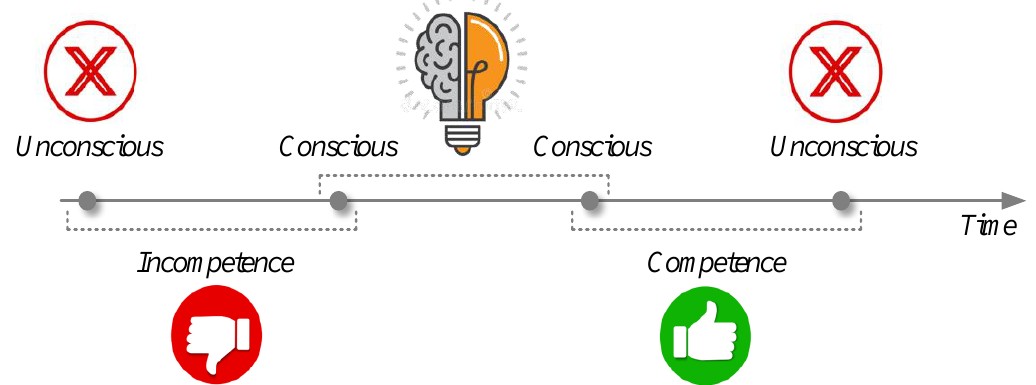
Figure 2. The classical model of professional competency development: Unconscious (one doesn't know that he/she doesn't have this skill or that he/she needs to acquire it); Conscious (one is aware that he/she doesn't have this skill); Conscious (one is aware that he/she has this skill); Unconscious (one doesn't know that he/she has this skill, as it seems easy and is done